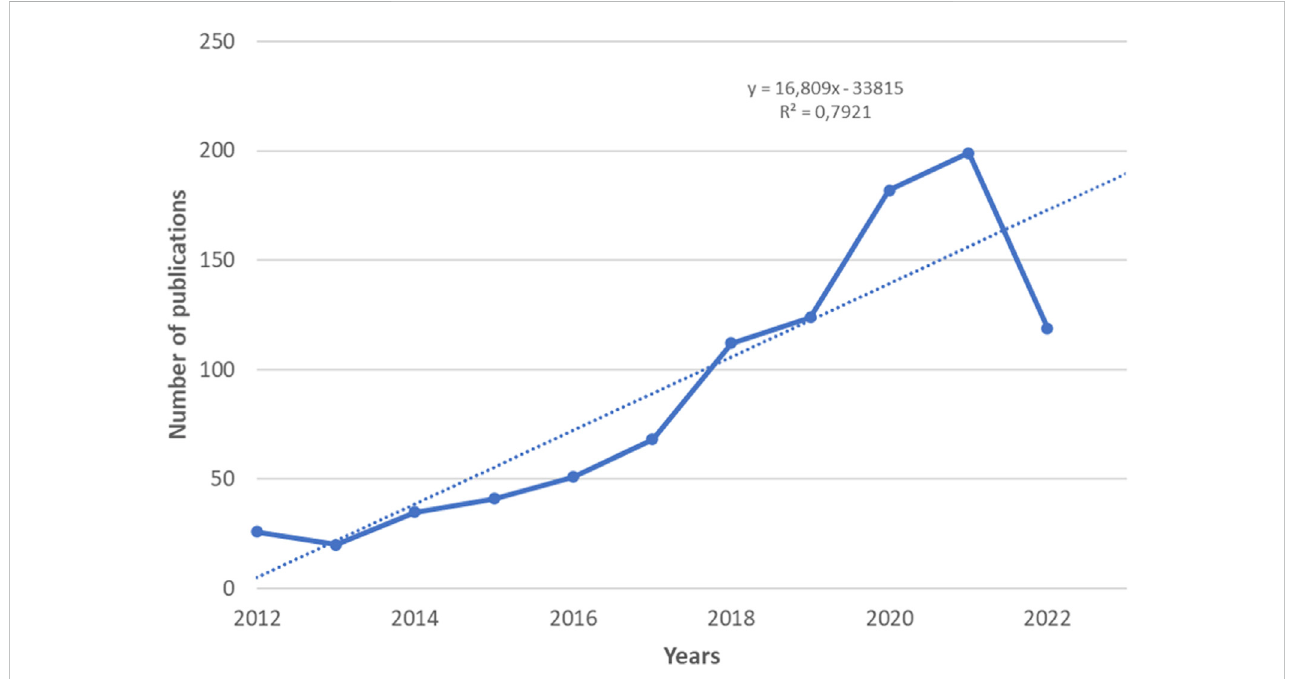
FIGURE 2 The dynamics of publications related to clinical trials of digital pills and their review papers for the period January 2012 to July